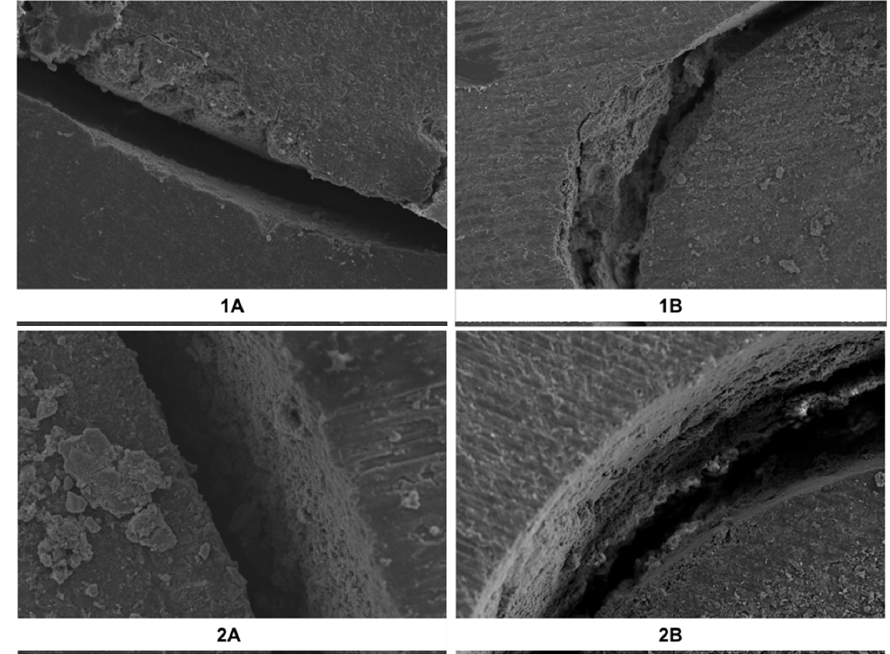
Figure 1. Representative SEM images of the interface demonstrating the failure modes. The figure shows a sample with adhesive failure in group ( 1A ), mixed failure from group (1B), adhesive failure from group ( 2A ), and cohesive failure from group ( 2B